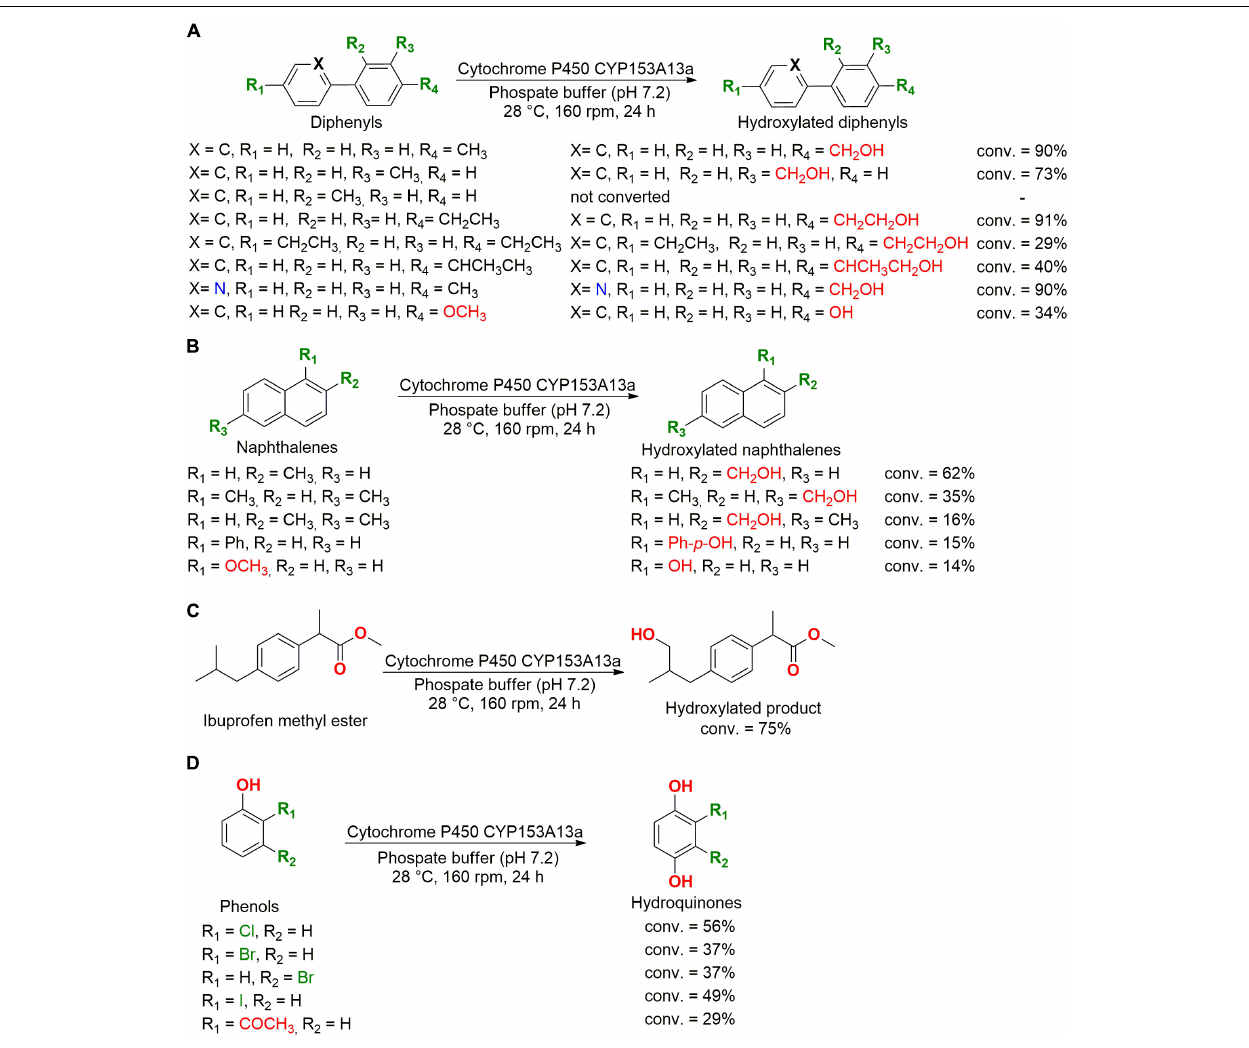
FIGURE 7 | Biotransformation of (A) diphenyls, (B) naphthalenes, (C) ibuprofen methyl ester, and (D) phenols by cytochrome P450 CYP153A13a (Otomatsu et al.,